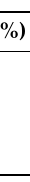
Table 4. Summary the proportion of CC in different